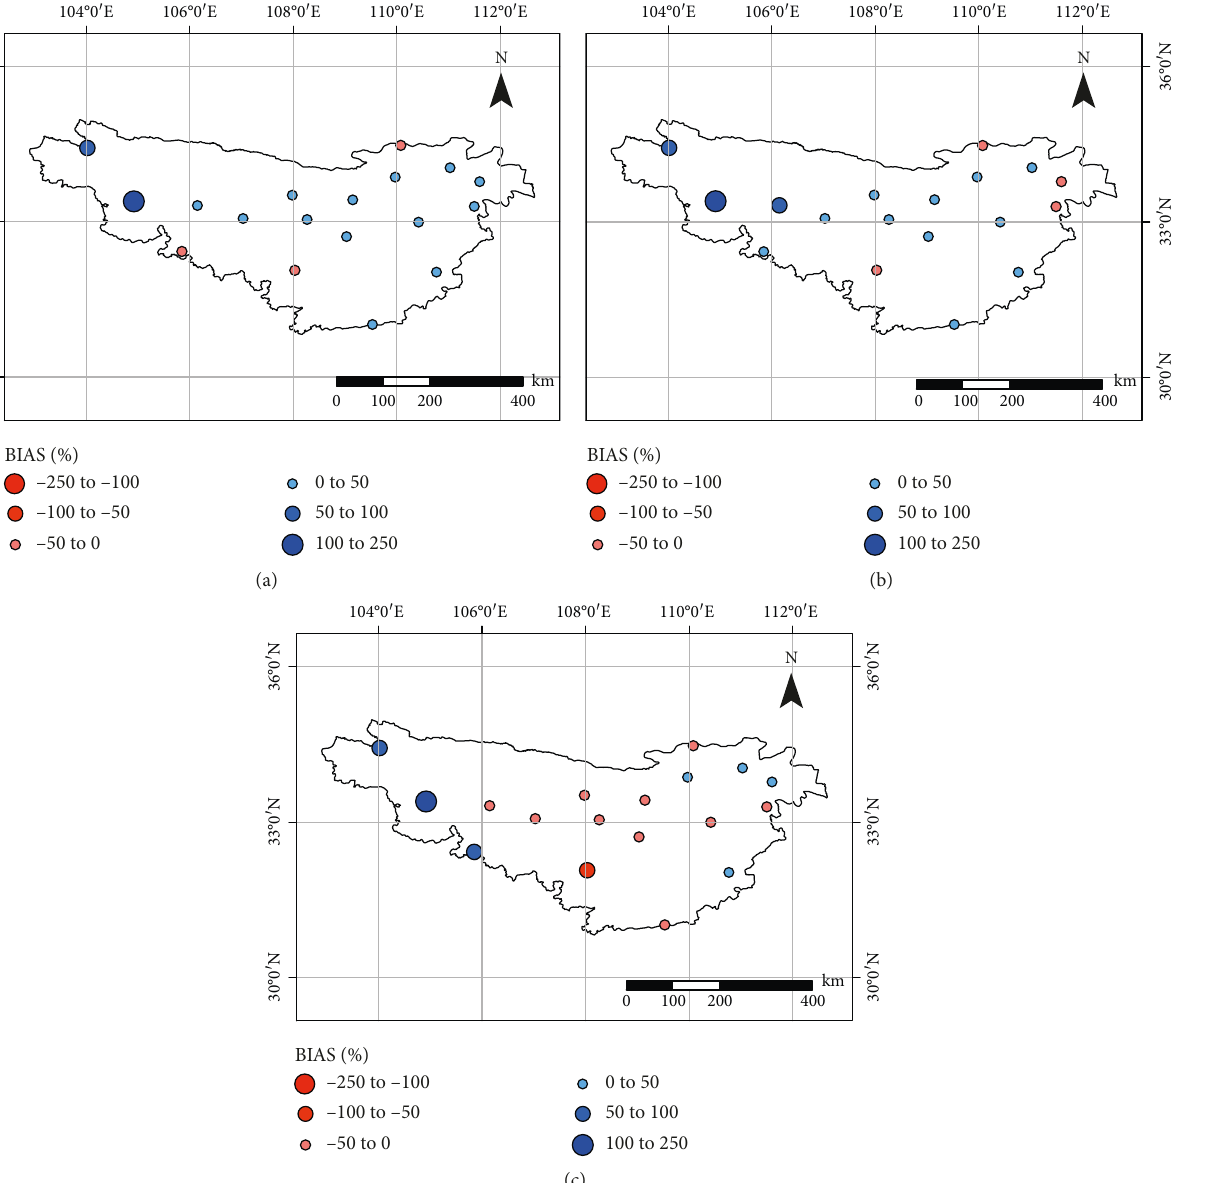
Figure 5: BIAS (%) at each gauge over the Qinling-Daba Mountains for monthly precipitation between (a) ERA-Interim and gauges, (b) JRA-55 and gauges, and (c) NCEP/NCAR-1 and